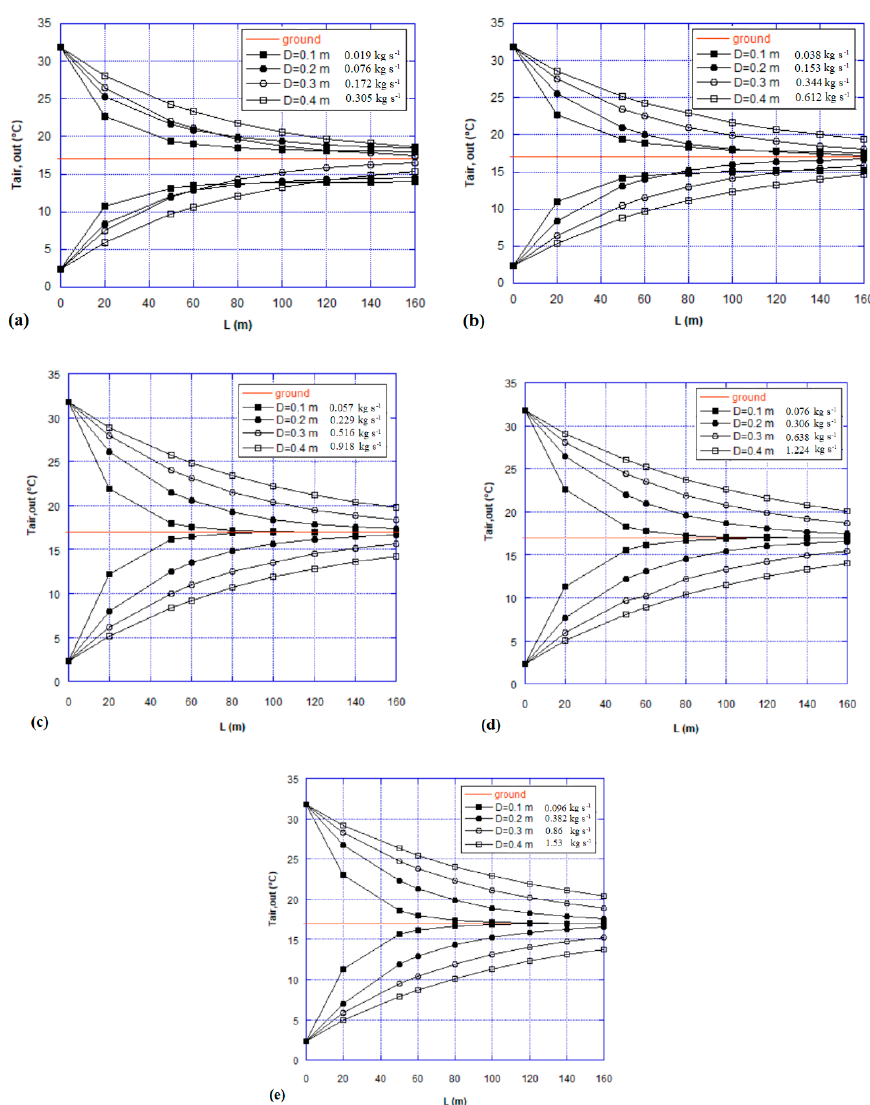
Figure 3. Outlet air temperature vs. length parametrized for diameter while the inlet air velocity is: